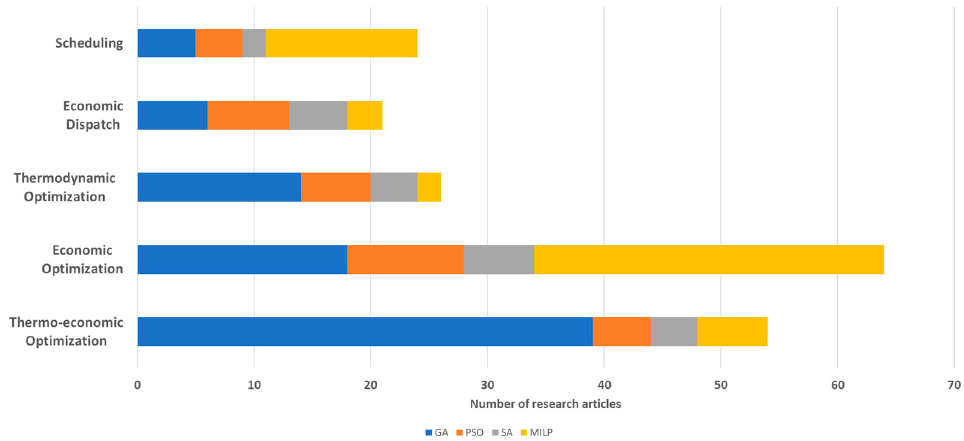
Figure 6. Statistical report of preliminary studies based on the optimization purpose and method.